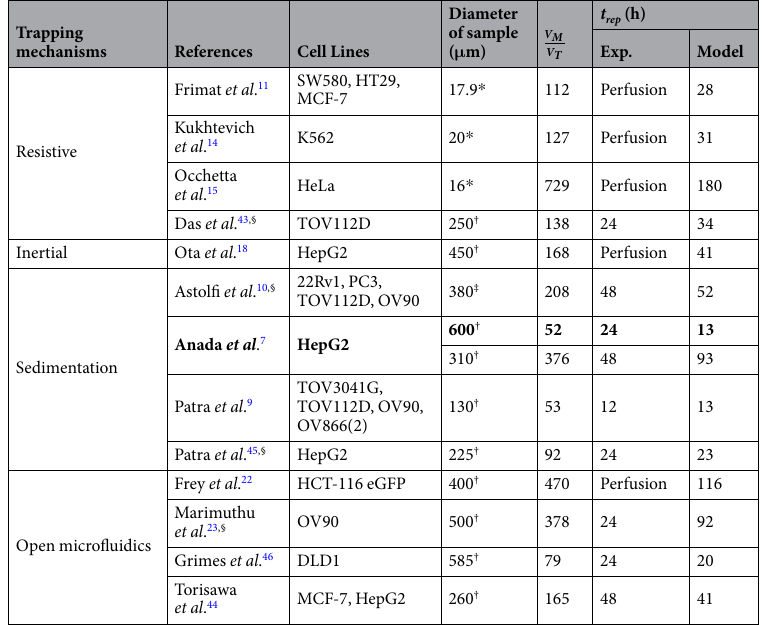
Table 4. Comparing experimental and model replenishment times t rep for several publications. * Single cells . † Spheroids . ‡ Micro-dissected tissue . § Our group